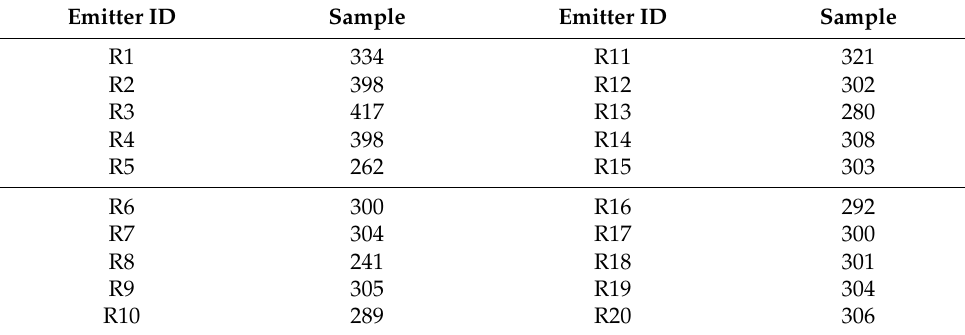
Table 1. Samples of Each Emitter for Dataset